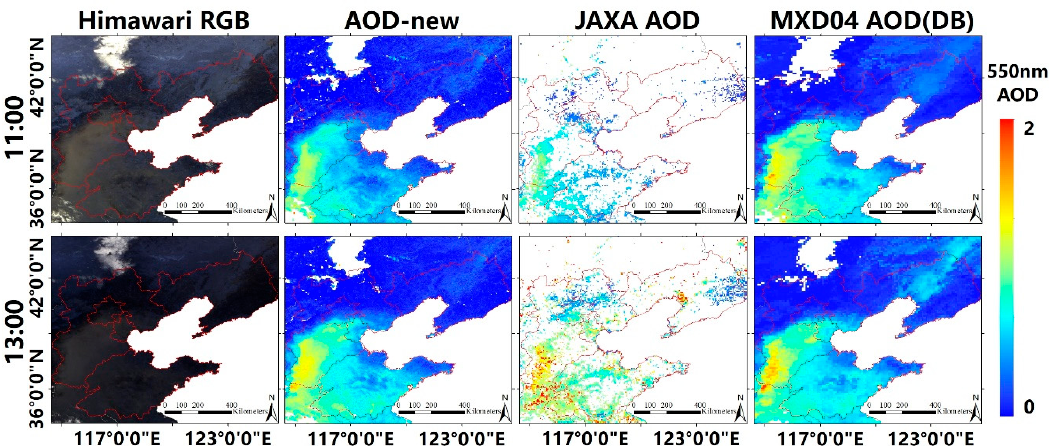
Figure 11. AOD retrieval results for our method compared with the JAXA level 2 AOD product and MODIS version 6.1 deep blue AOD product over Bohai Rim region, China, on the 1st November in 2018.